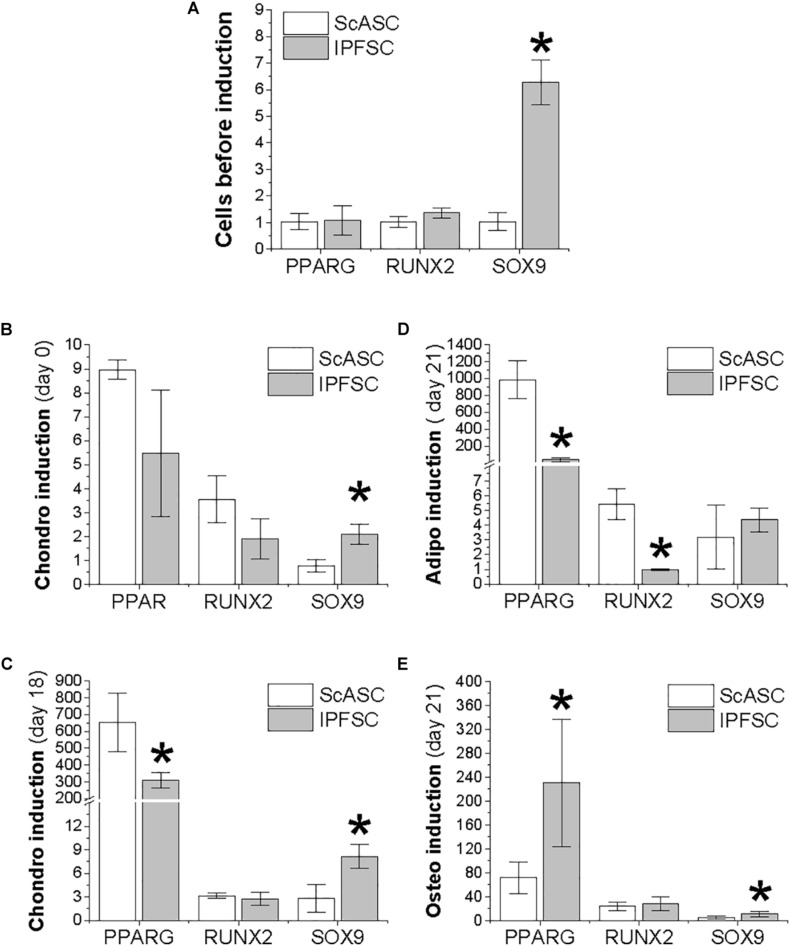
Expression of transcription factors in ScASCs (n = 4) and donor-matched IPFSCs (n = 4) measured by qPCR. SOX9, PPARG, and RUNX2 were used to represent chondrogenesis, adipogenesis, and osteogenesis, respectively. Expanded cells were evaluated before induction (A) and after induction (B–E): (B) 24 h after centrifugation to form a pellet but before chondrogenic induction; (C) 18 days after chondrogenic induction; (D) 21 days after adipogenic induction; and (E) 21 days after osteogenic induction. Data are shown as bar charts. Expression of each target gene in undifferentiated IPFSCs (A) and differentiated ScASCs/IPFSCs (B–E) is plotted against undifferentiated ScASCs (A), which is set as “1”. * indicates a significant difference compared to the corresponding control group (p < 0.05).